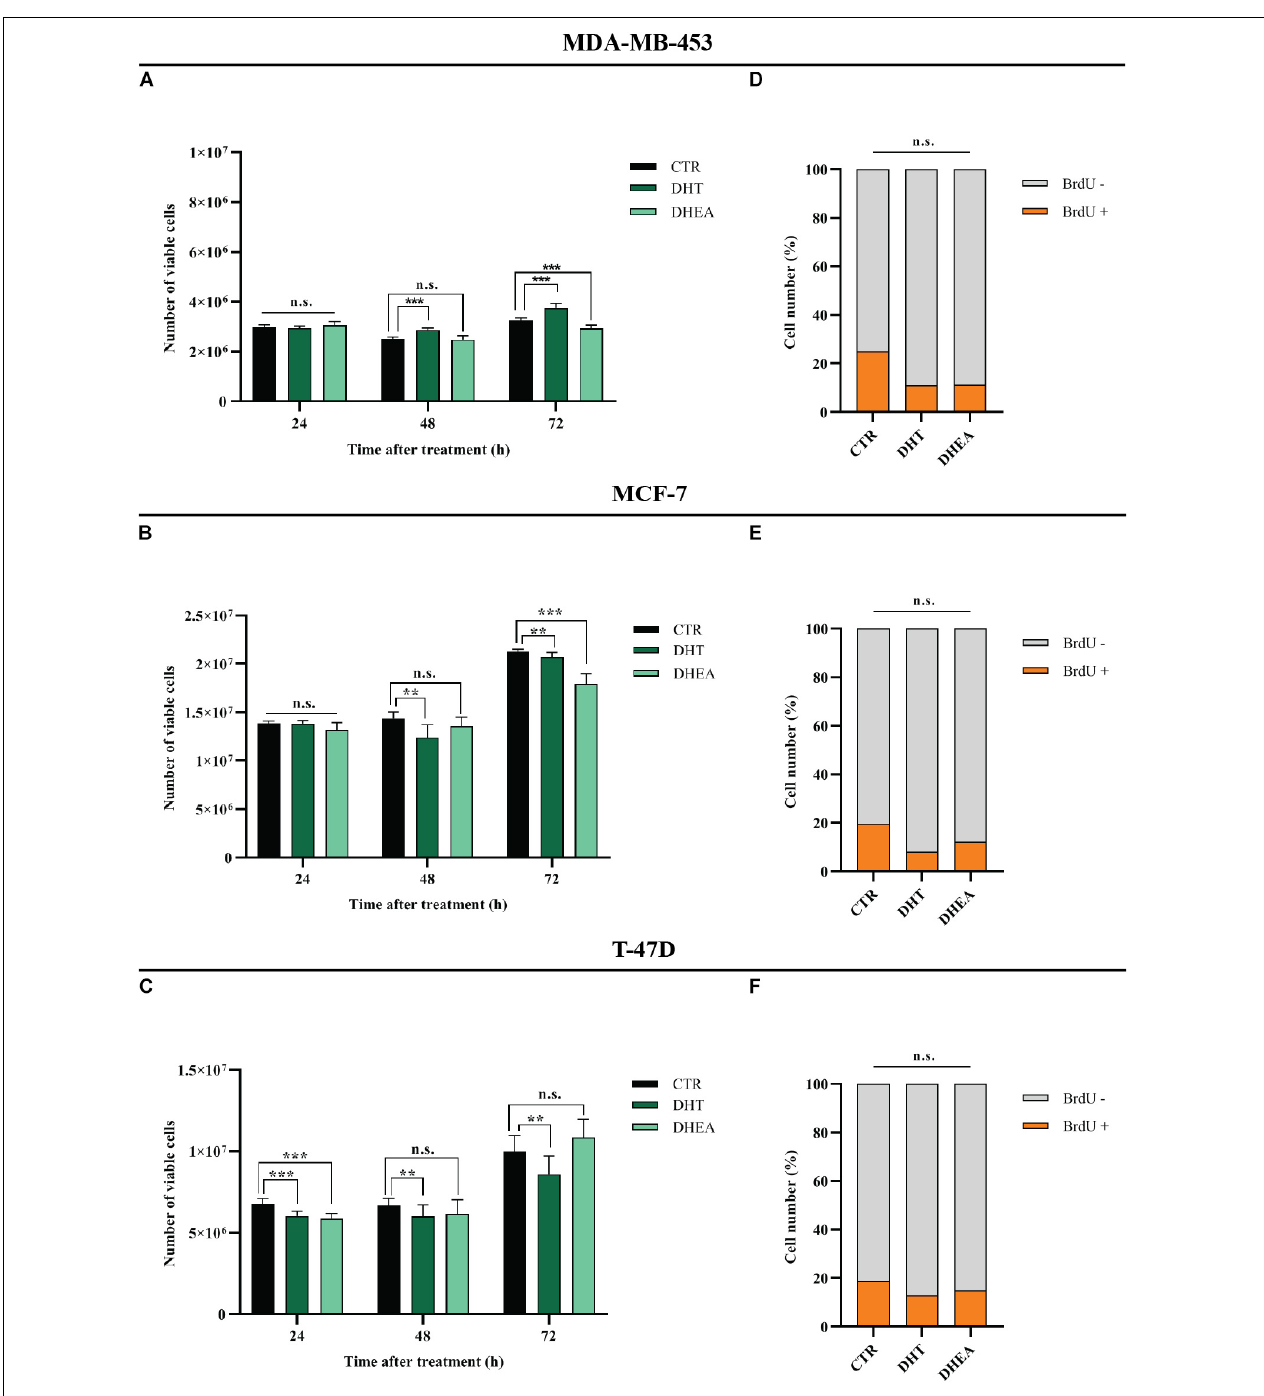
FIGURE 5 | Effect of DHT and DHEA on proliferation of BC cell lines at the indicated time points (A–C) and on DNA replication at 48 h post-transfection (D–F) . ** p < 0.01, *** p < 0.001, n.s., not significant. Multiple t -test, corrected for multiple comparison using the Holm-Sidak method in (A–F) .